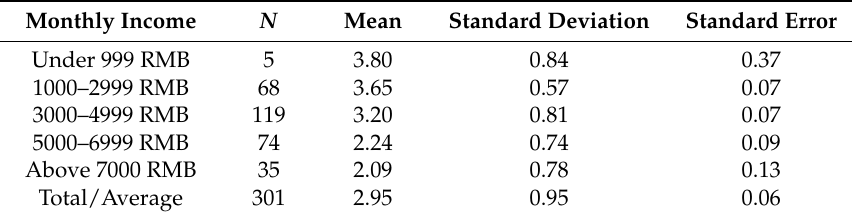
Table 6. Description of different income